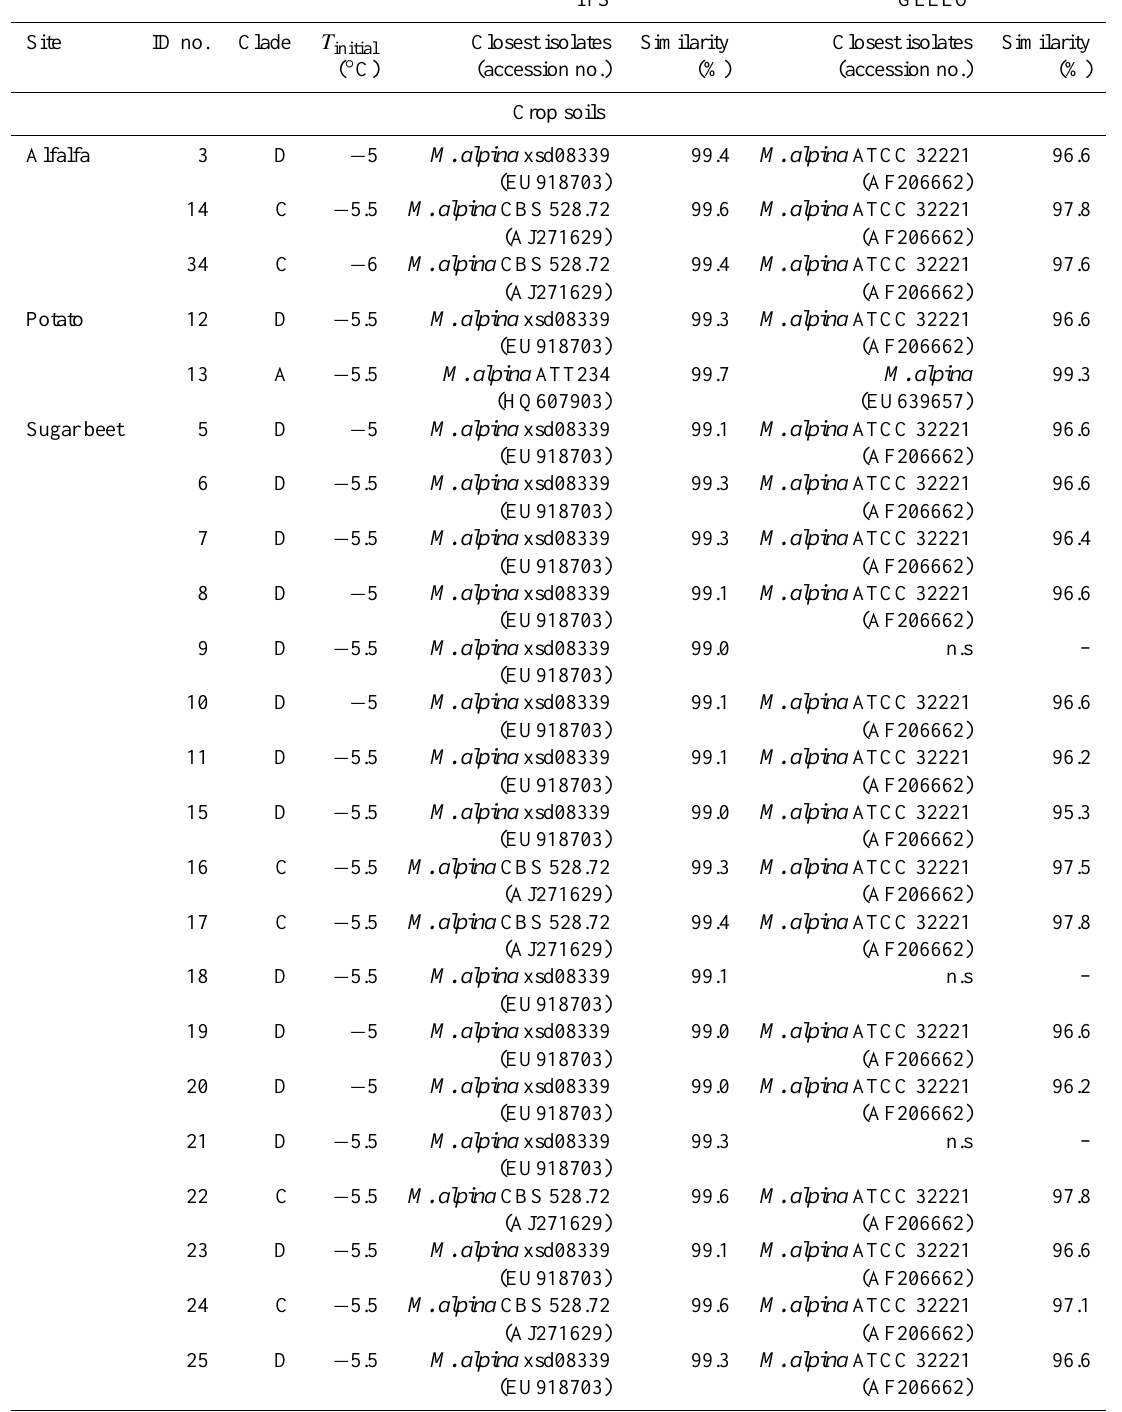
Table 3. Characteristics of M. alpina isolates. Site, ID number, phylogenetic clade, highest observed initial freezing temperature ( T i ) , and closest GenBank matches and similarity for ITS and GLELO; n.s. stands for no